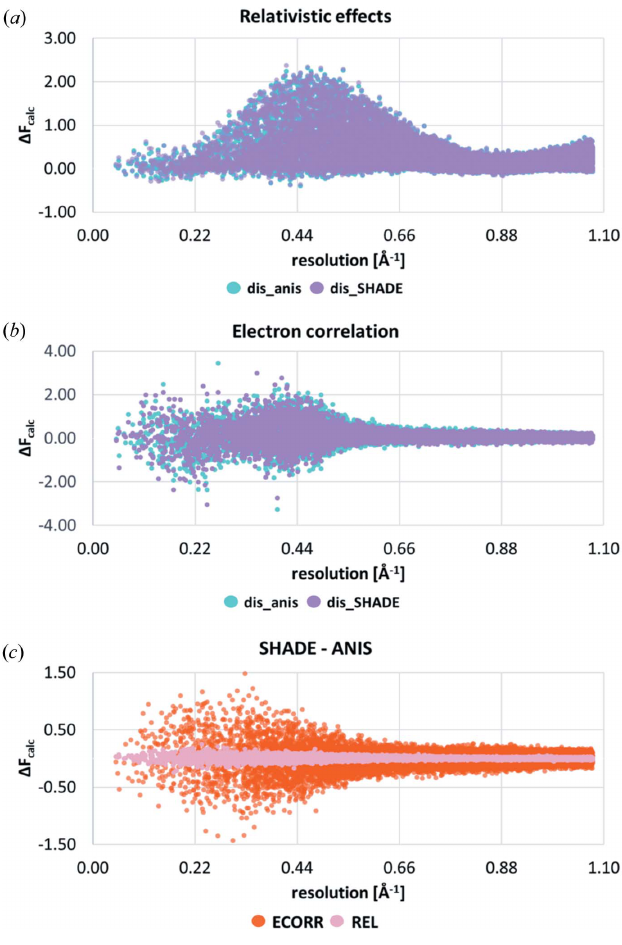
Figure 7 Differences in dynamic structure factors showing the effects of modelling disorder on the distribution of differences in the calculated dynamic structure factor amplitudes due to relativistic effects and electron correlation. On the x axis, sin (cid:4) / (cid:2) (A˚ (cid:5) 1 ) is plotted up to the maximum experimental resolution. On the y axis, the difference in calculated dynamic structure factors is plotted in absolute scale ( (cid:2) F calc ).